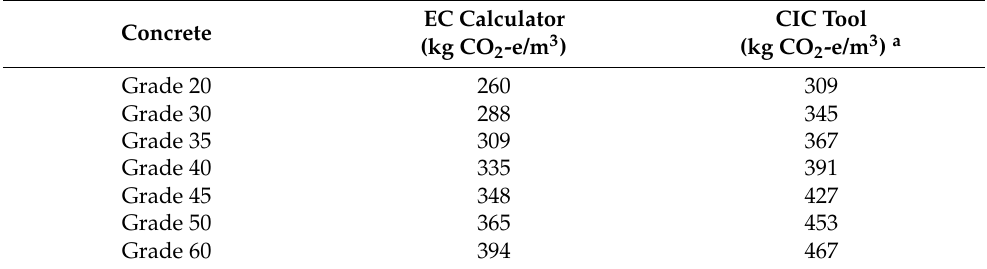
Table 4. Comparison of concrete emission factors used in the calculation. Concrete